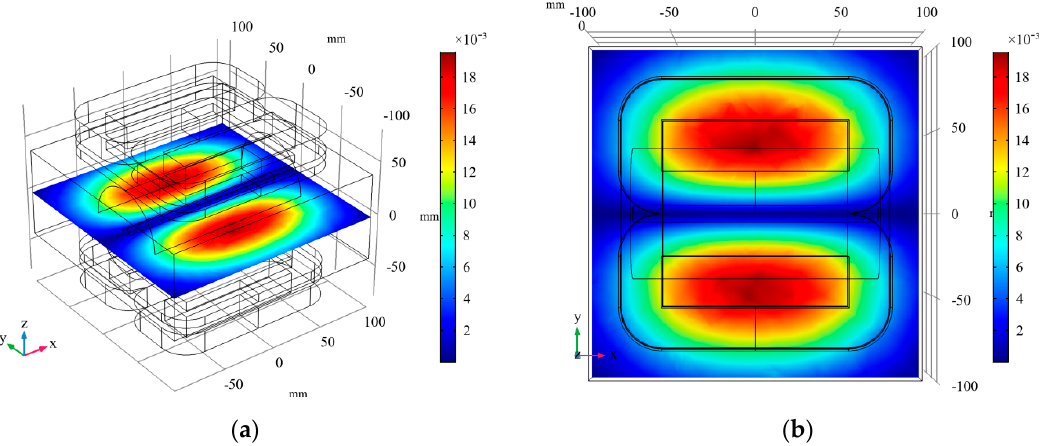
Figure 7. The magnetic flux density modulus distribution of the linear gradient field generated by the gradient coils. ( a ) 3D view; ( b ) x–y view.